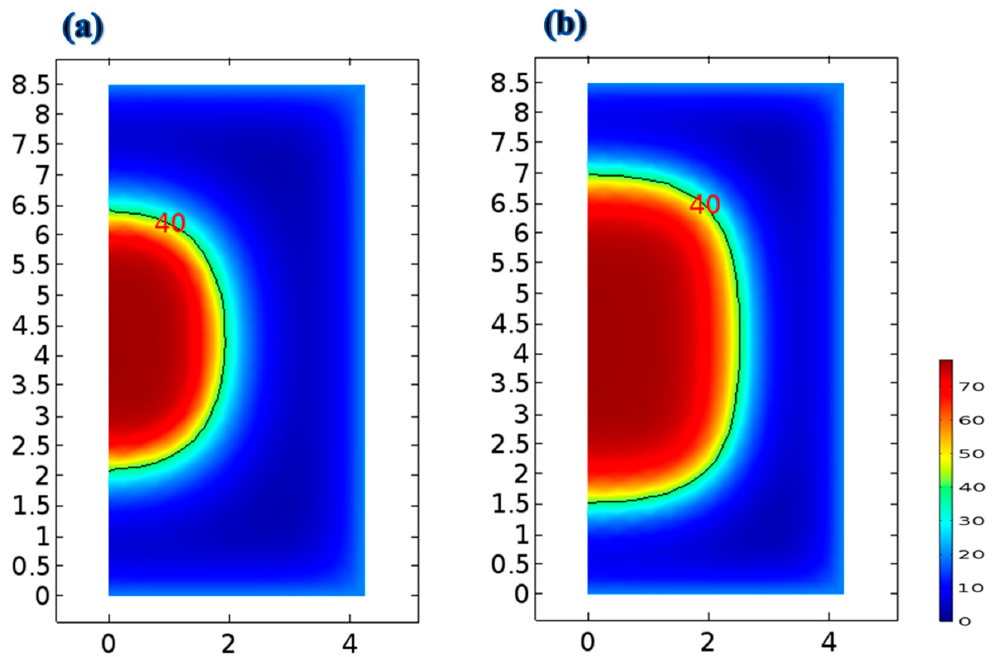
Figure 8. Distributions of the water content in the strip after 9 min of frying: ( a ) without the temperature step frying approach at 170 °C and ( b ) with the temperature step frying approach at 170 °C.